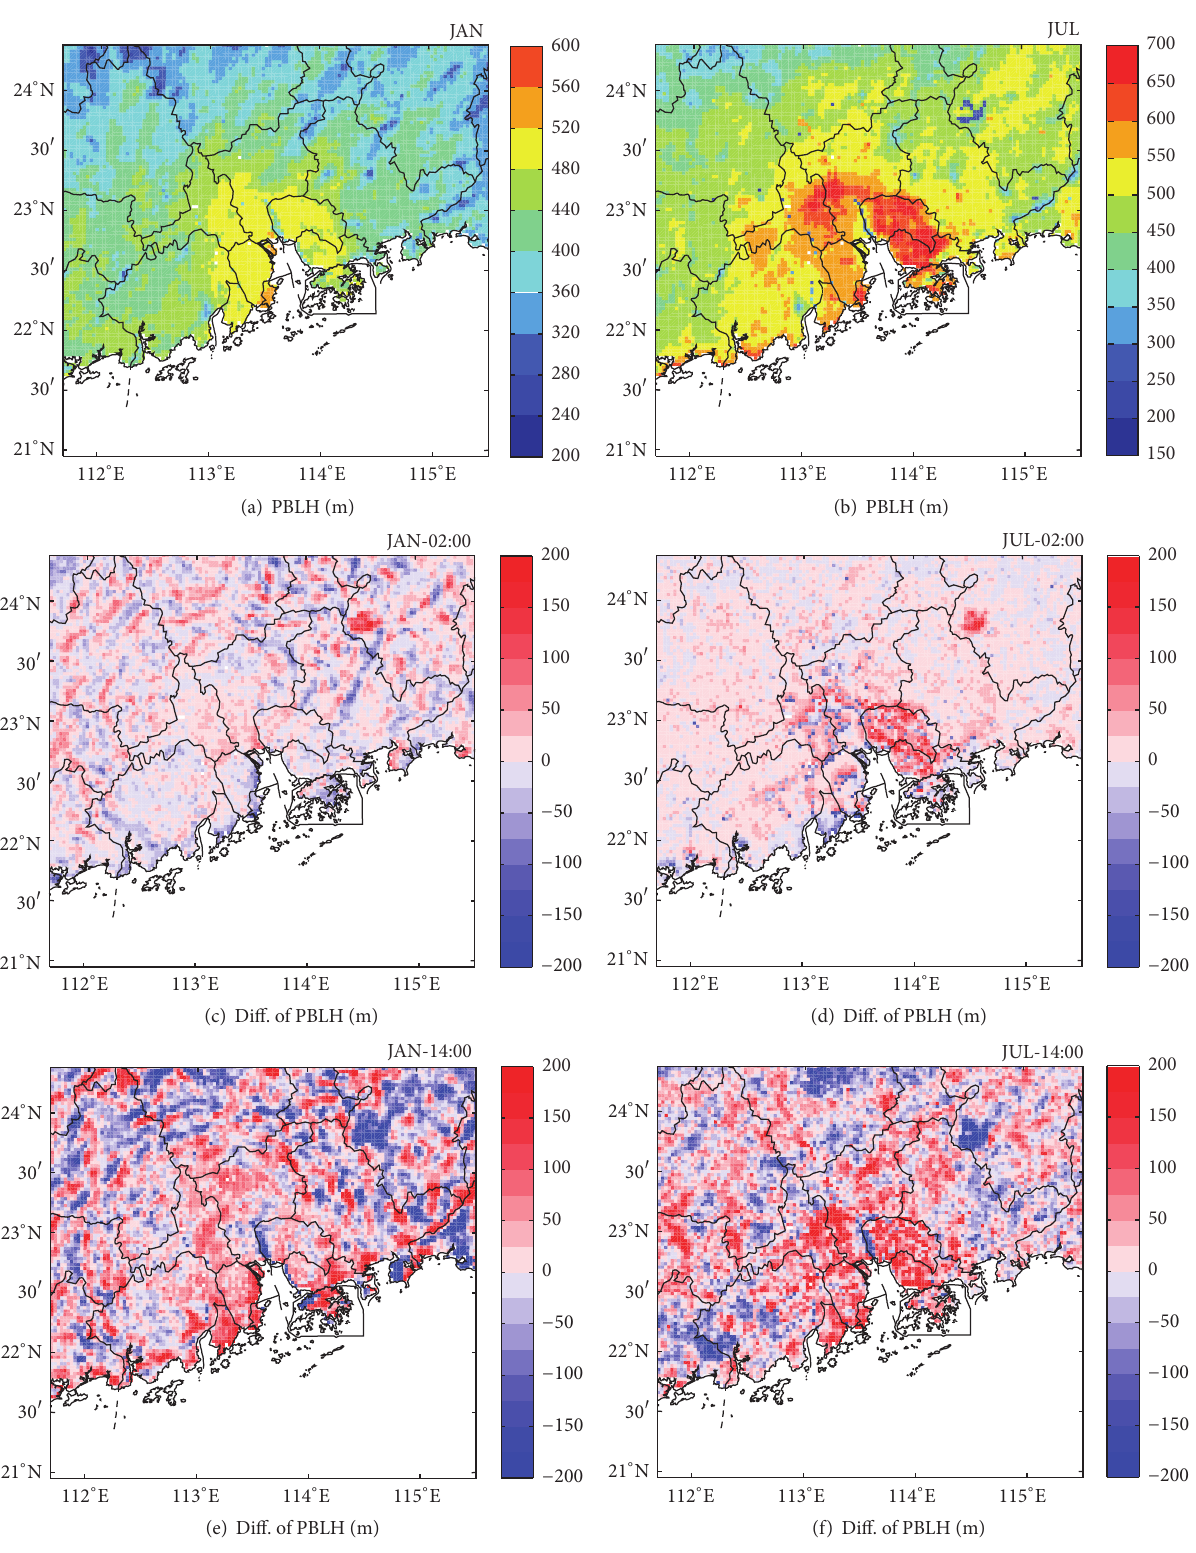
Figure 6: The simulated spatial distribution of monthly-average PBLH (m) in the GLC2009 case (a, b) and spatial distribution of PBLH differences(m)at02:00LST(c,d)and14:00LST(e,f)betweentheGLC2009caseandtheGLC2000case(differences=GLC2009 −